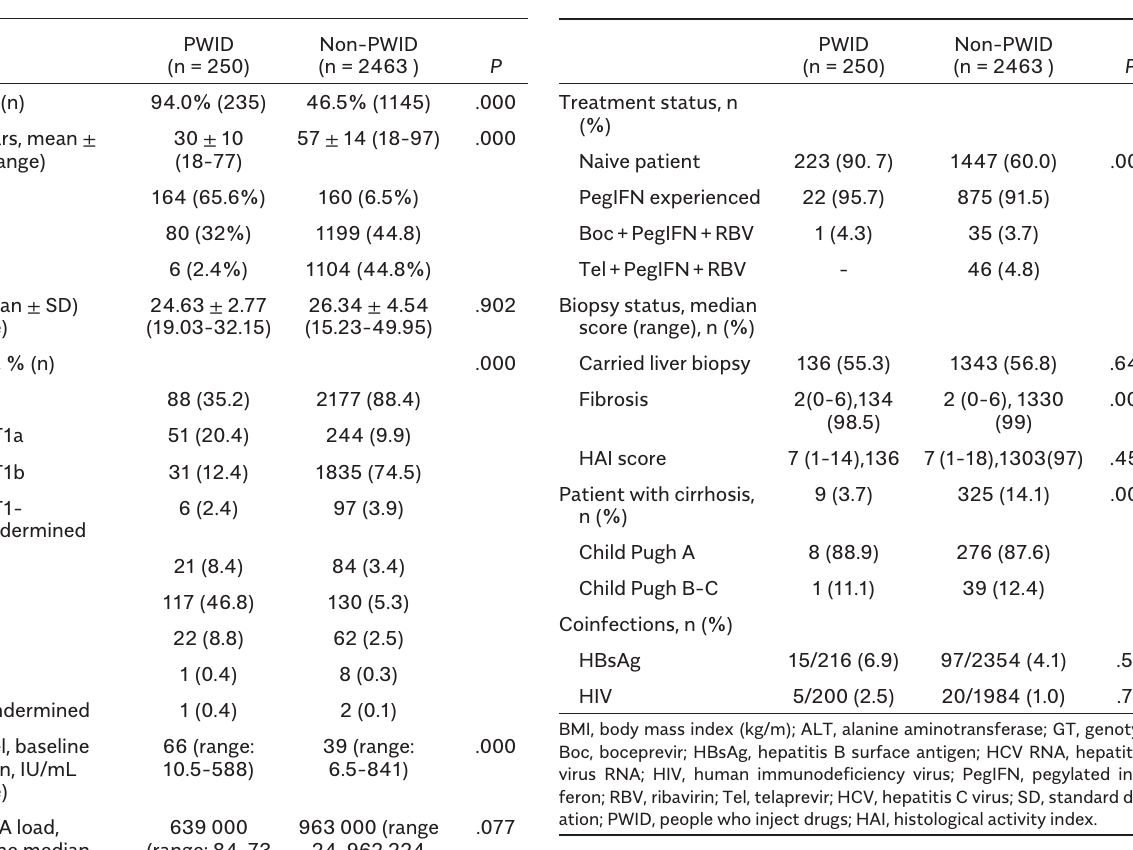
Table 2. Demographic and Baseline Characteristics of the